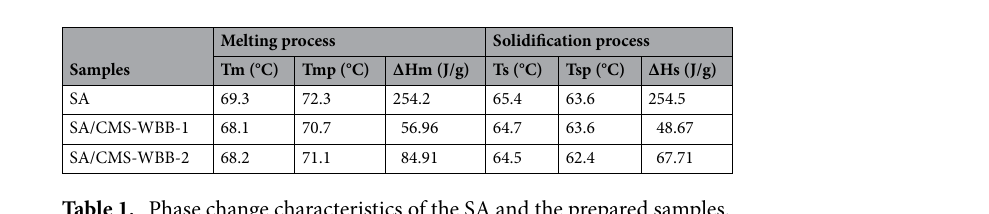
Table 1. Phase change characteristics of the SA and the prepared